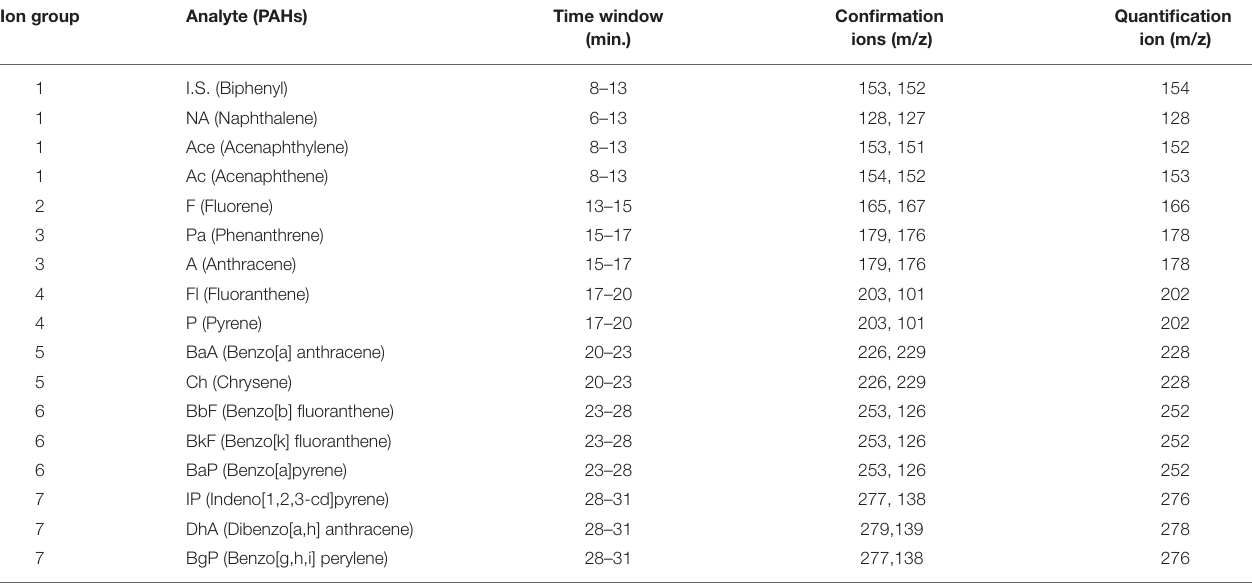
TABLE 1 | Selected ions applied for the qualification and quantification of PAH compounds by GC-MS (SIM mode). Ion group